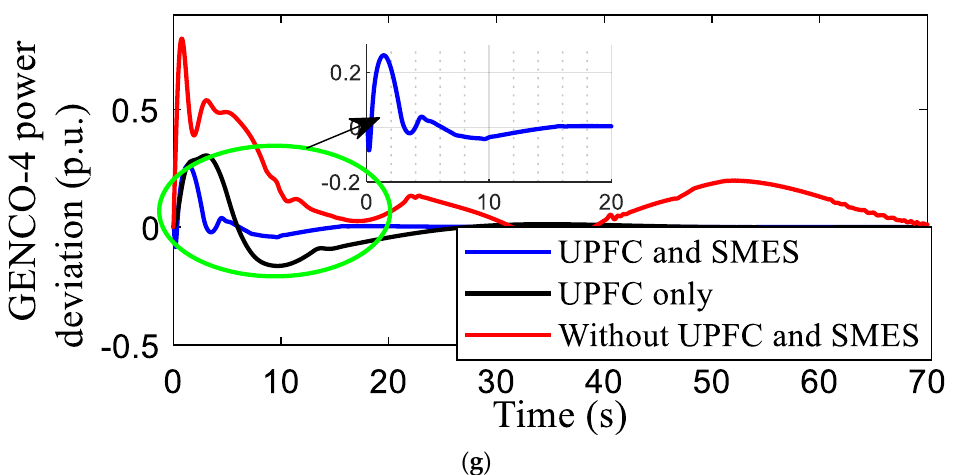
Figure 12. Dynamic performance of Test-2: ( a ) frequency deviation in area-1; ( b ) frequency deviation in area-2; ( c ) tie-line power deviation; ( d ) GENCO-1 power deviation; ( e ) GENCO-2 power deviation; ( f ) GENCO-3 power deviation; ( g ) GENCO-4 power deviation.